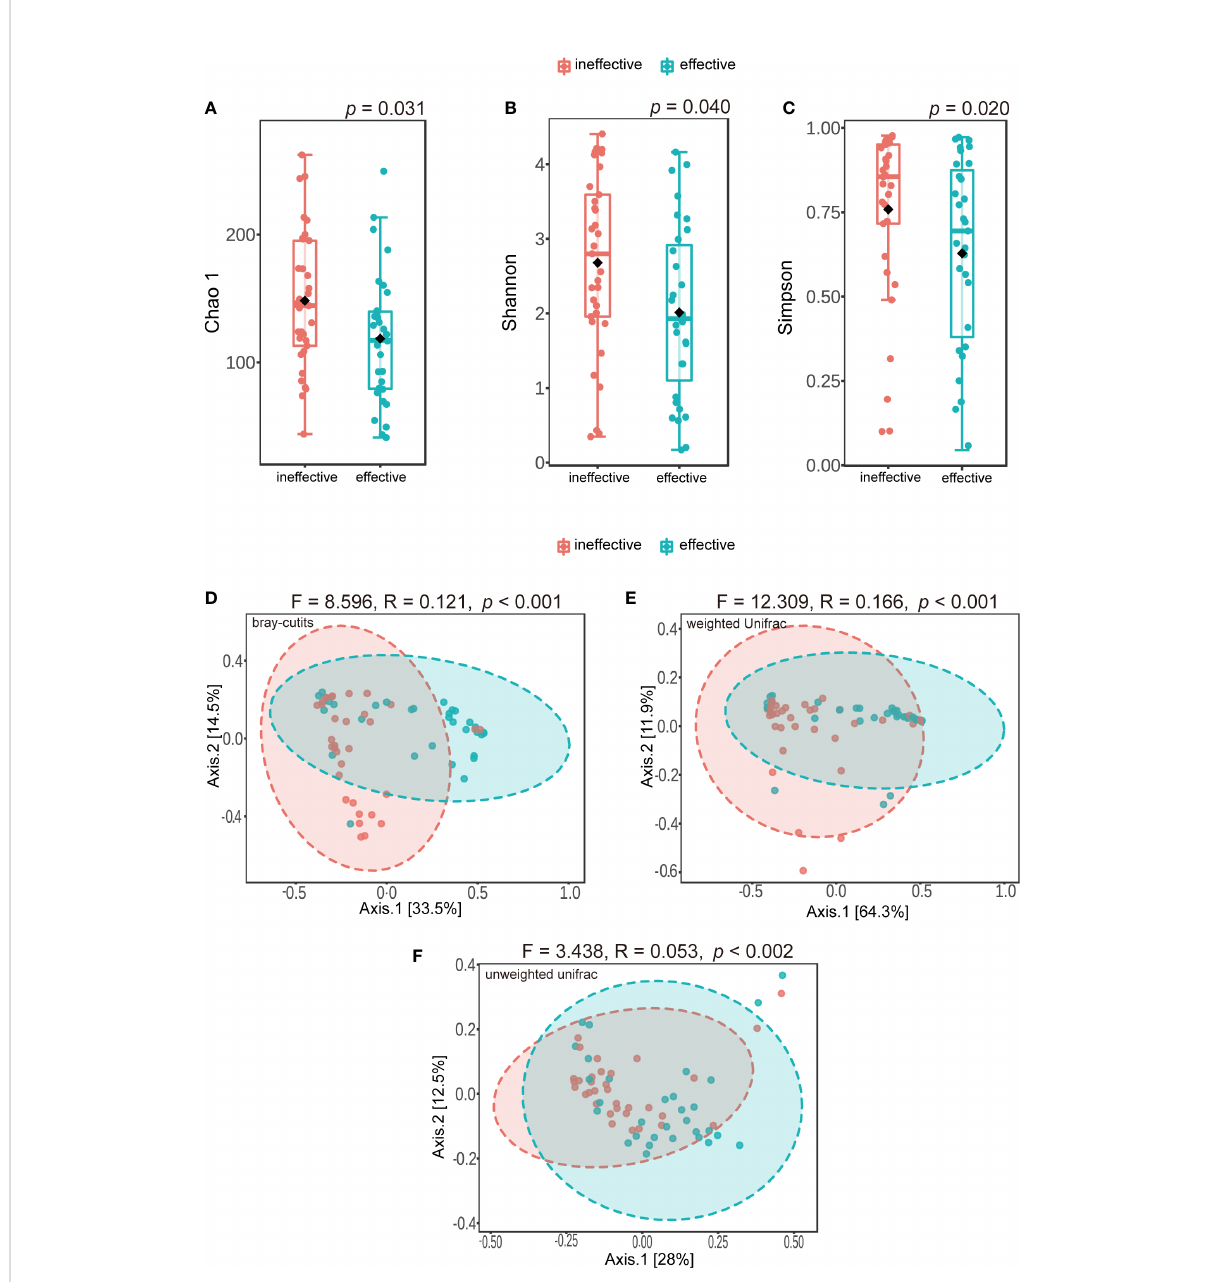
FIGURE 2 Alpha-diversity and principal coordinate analysis for urinary microbiomes between ineffective group and effective group. (A) Chao 1 (B) ; Shannon index (C) ; Simpson index (D) ; Principal coordinate analysis plot of the urinary microbiome based on bray-curits (E) ; or weighted Unifrac (F) ; or unweighted